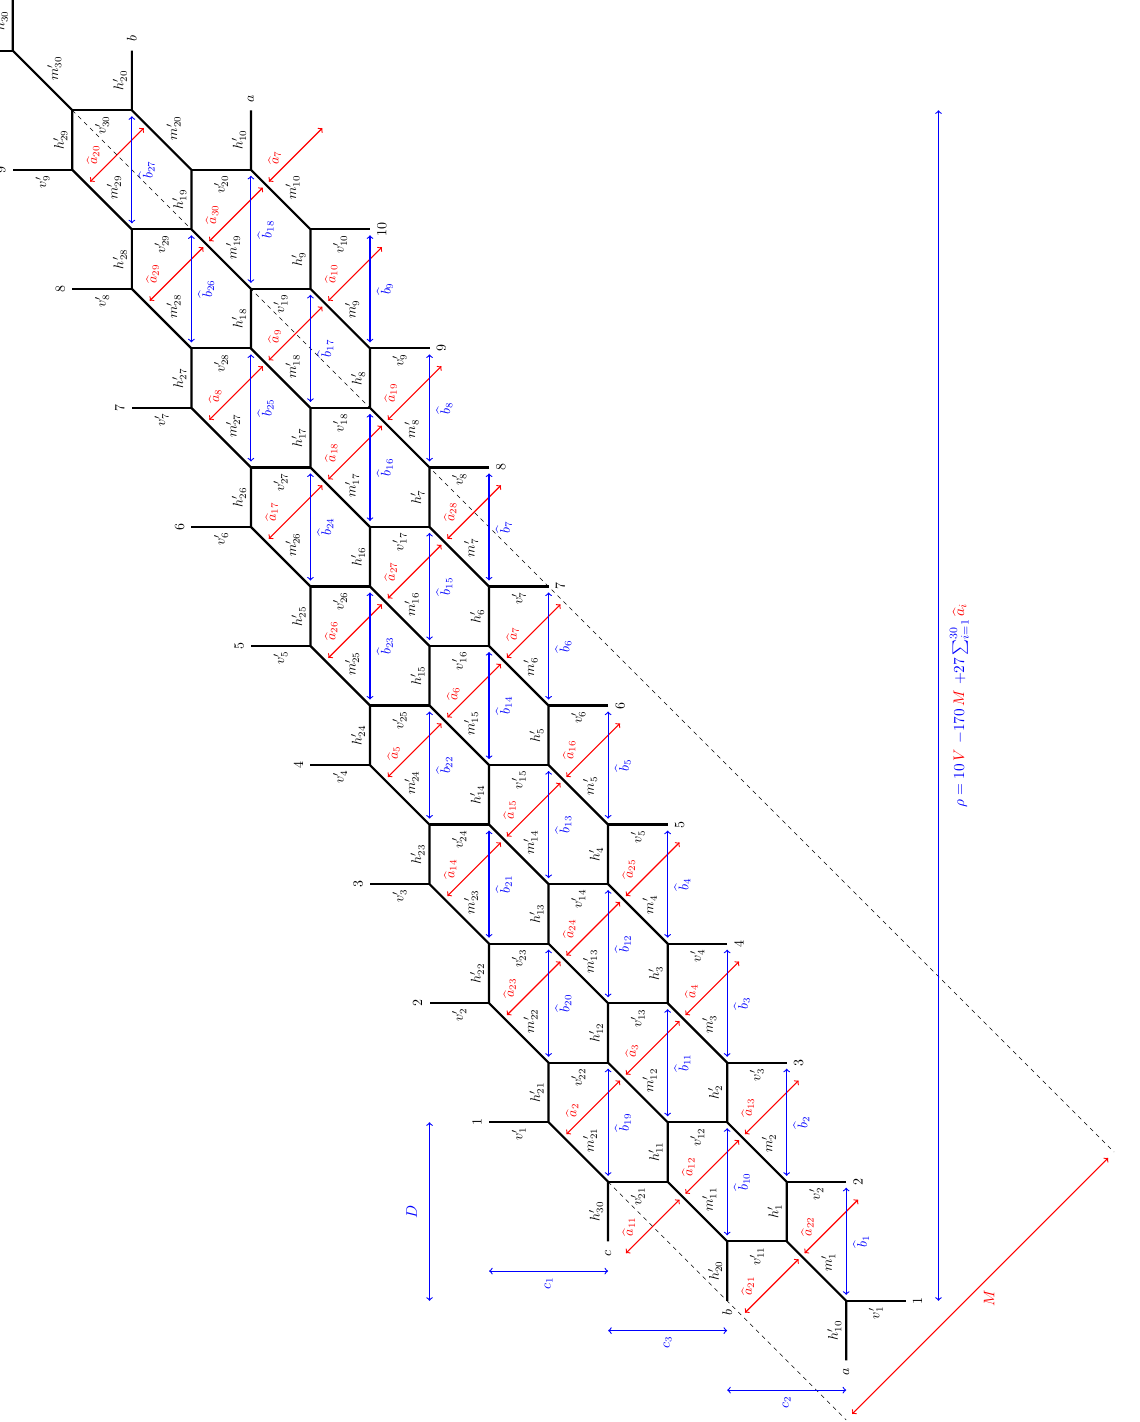
Figure 6 . Two di(cid:11)erent maximal sets of independent K(cid:127)ahler parameters in the (10 ; 3) web diagram. After a series of suitable (cid:13)op- and symmetry transformations, the red parametrisation agrees with the maximal set of independent parameters ( M; V; a 1 ;:::; 30 ) used in the (6 ; 5) web diagram in (cid:12)gure b